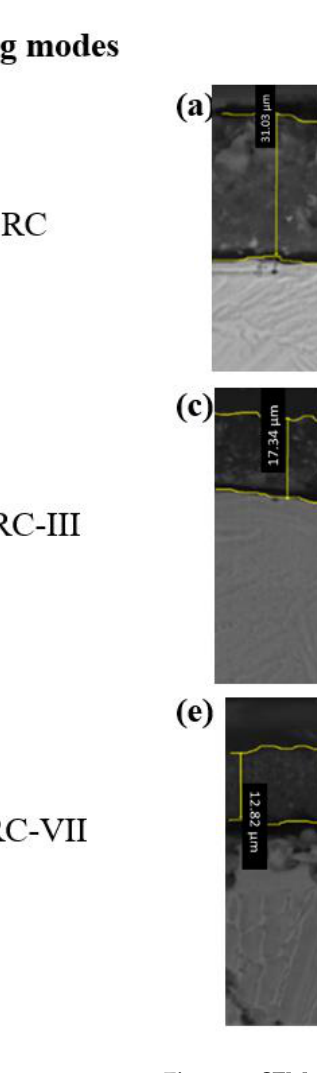
Figure 8. SEM micrographs under different cutting modes that show the transverse surface along with the thickness measurements of recast layer.